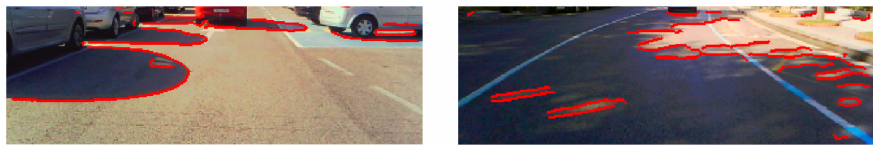
Figure 3. Shadow edge detection of images in Figure 2 obtained using Property 1, i.e., Equation